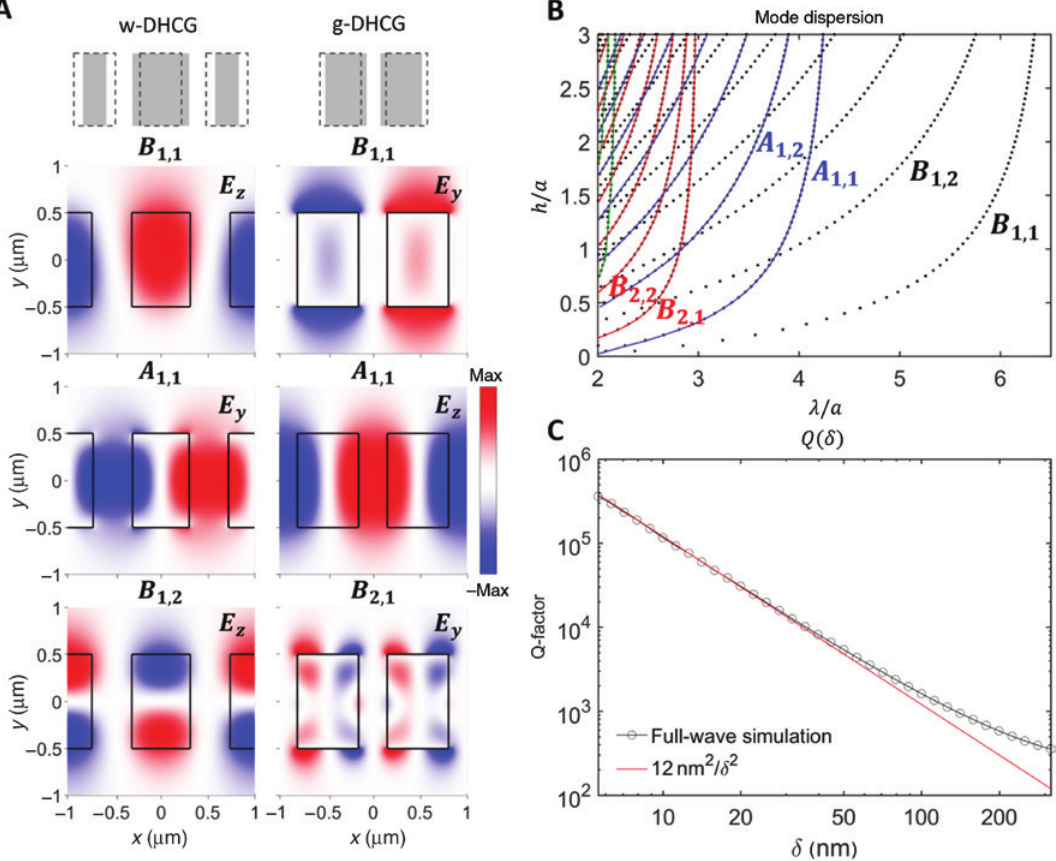
Figure 2: Mode properties. (A) Example mode profiles for w-DHCGs (left) and g-DHCGs (right). TE light ( E component shown) excites bonding modes and TM light z ( E component shown) excites anti-bonding modes for w-DHCGs. Instead, TM light excites bonding modes and TE light excites anti-bonding y modes for g-DHCGs. (B) Mode dispersion of TE excitation calculated by the scattering matrix method. Several distinct sets of modes are apparent and can be catalogued as bonding ( B ) and anti-bonding ( A ), where ( m , n ) are the number of lobes in the ( x , y ) directions in each mn mn grating finger. A similar plot can be constructed for TM. (C) The Q-factor, Q , extracted from FDTD simulations for a w-DHCG, where the per- turbation δ is the difference in widths of each finger. The expected relation Q = C / δ 2 holds with C ≅ 12 nm 2 at small perturbation but breaks down when the perturbation becomes